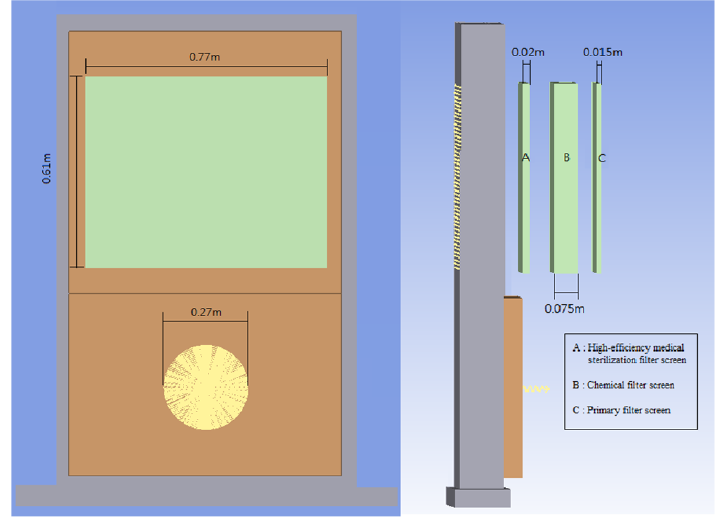
Figure 3. Air purifier filter setting diagram.